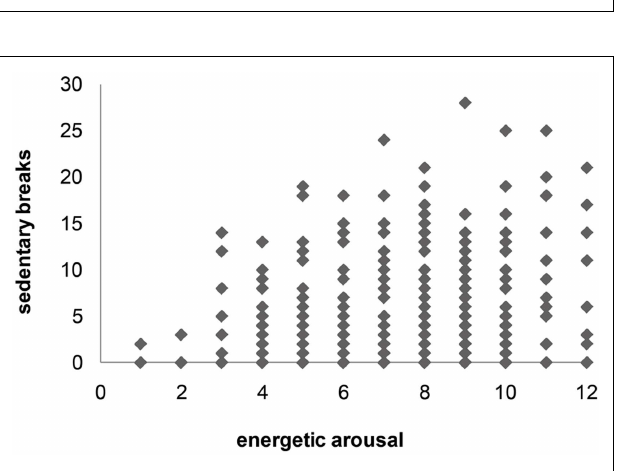
FIGURE 2 | Scatter plot of E (energetic arousal) score and amount of minutes spent in light activity (during 15min interval).